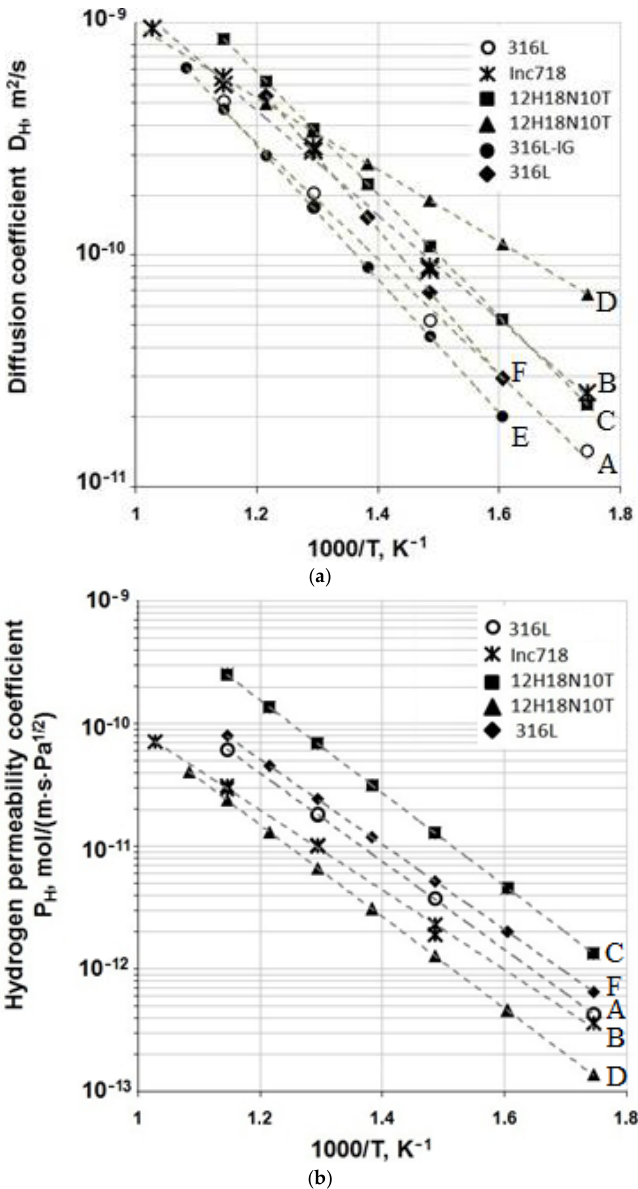
Figure 6. Temperature dependence of the diffusion coefficient ( a ) and permeability polytherm ( b ) for the researched materials. A,B –data for SLM-processed 316L and Inconel 718, respectivetly, obtained in this work, C – values for 12H18N10T from ref. [32], D – values for 12H18N10T from ref. [33], E – values for 316L-IG from ref. [34], F – values for 316L from ref. [35].